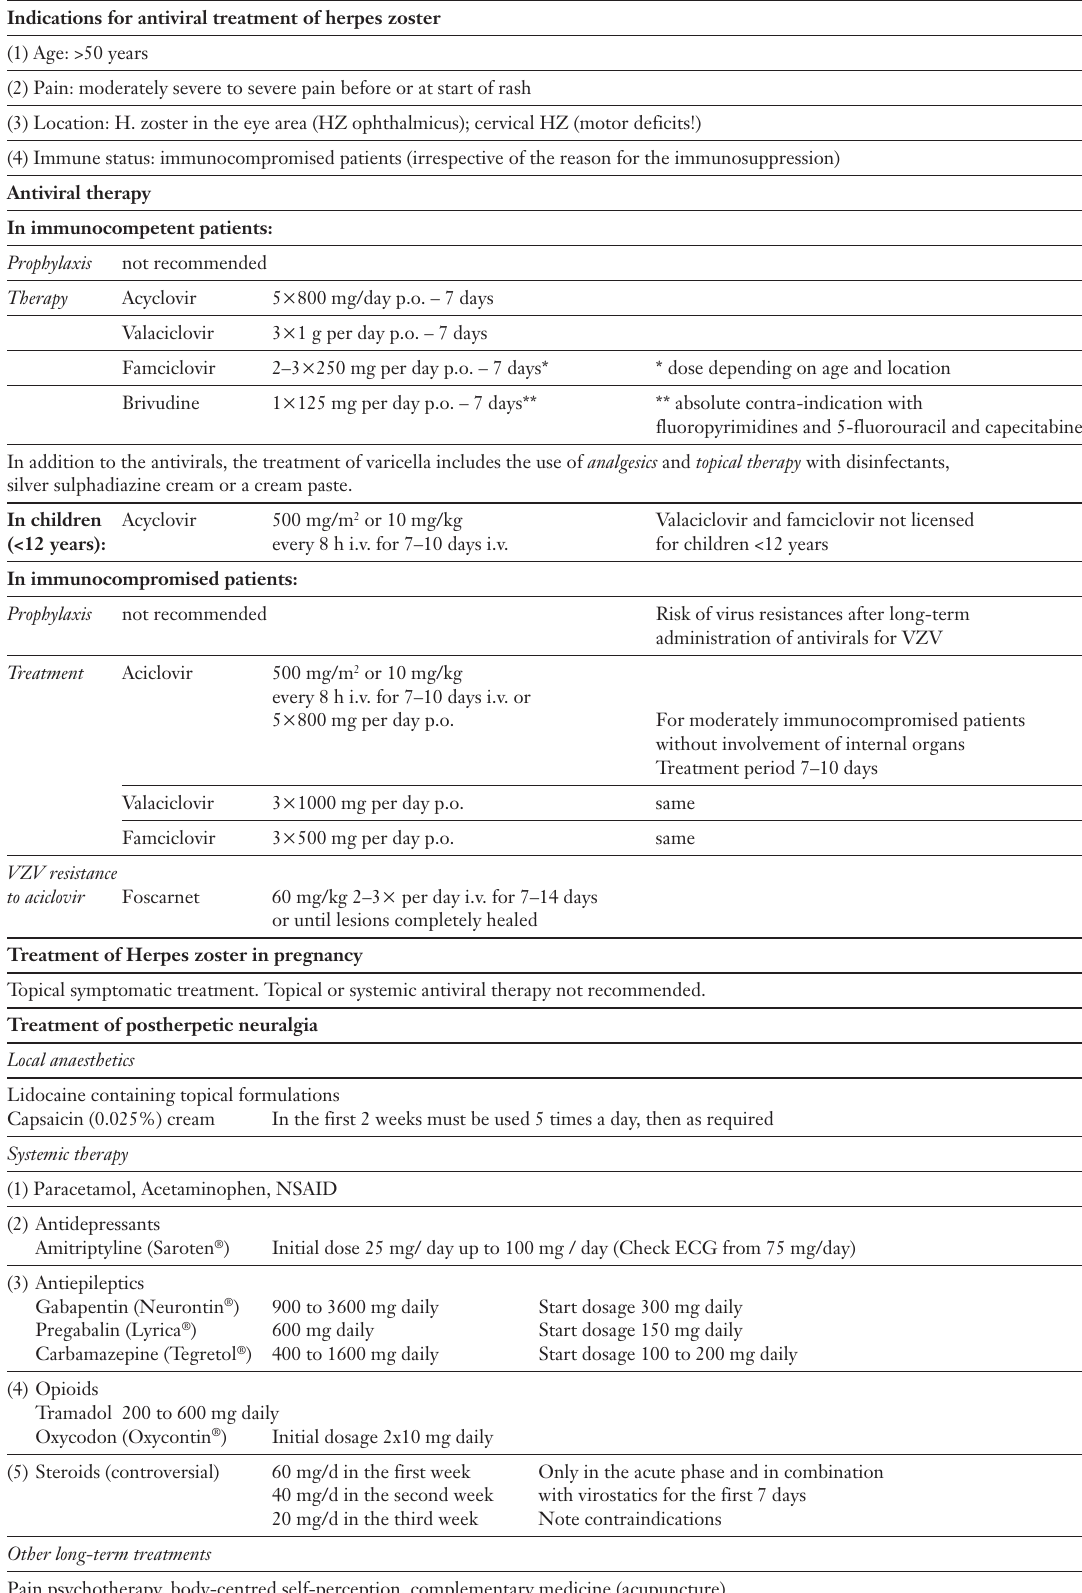
Antiviralprophylaxis and treatment of herpes